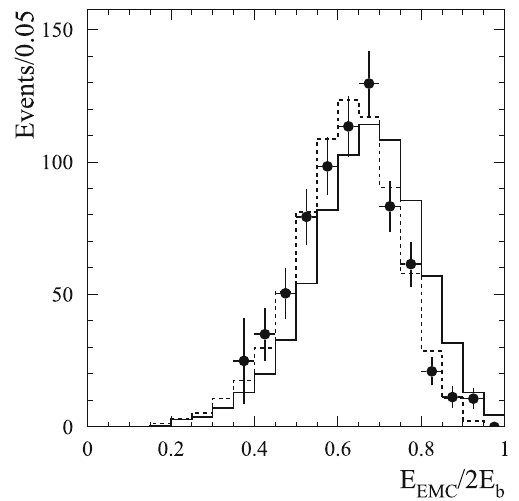
Fig. 12 The E EMC / 2 E b distribution for data n ¯ n events (points with error bars) of the 2019 run with E b = 945, 950, 951, 956 MeV (left panel), and with E b = 963, 973, 988 MeV (right panel). The solid histogram represents the same distribution for simulated n ¯ n events.